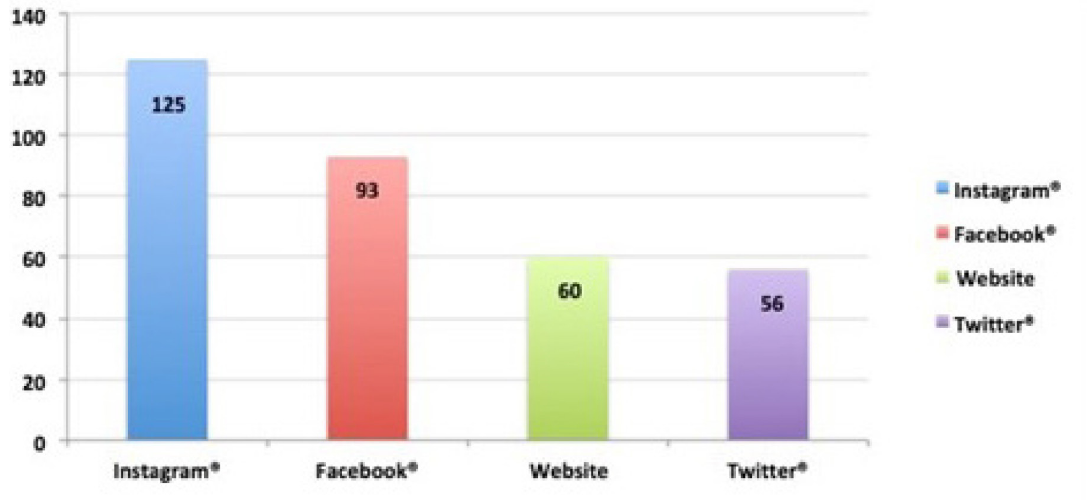
Fig. 1 - Number of surgeons using social media according to their